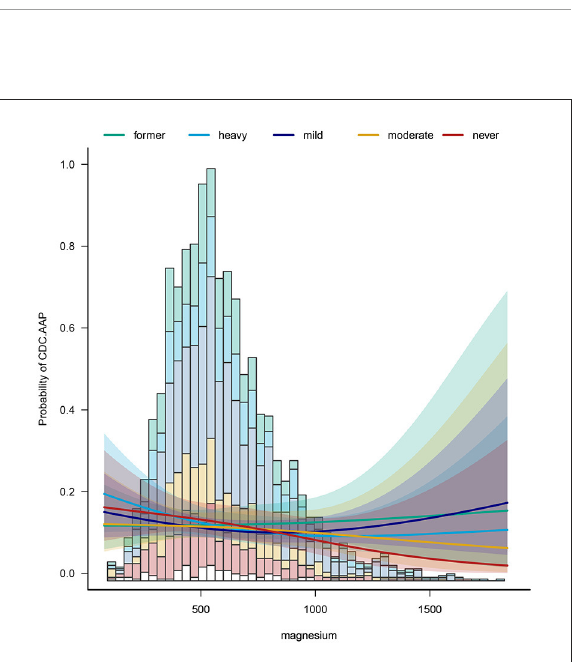
FIGURE3 The relationship between dietary magnesium intake on the prevalence of periodontitis in participants with different